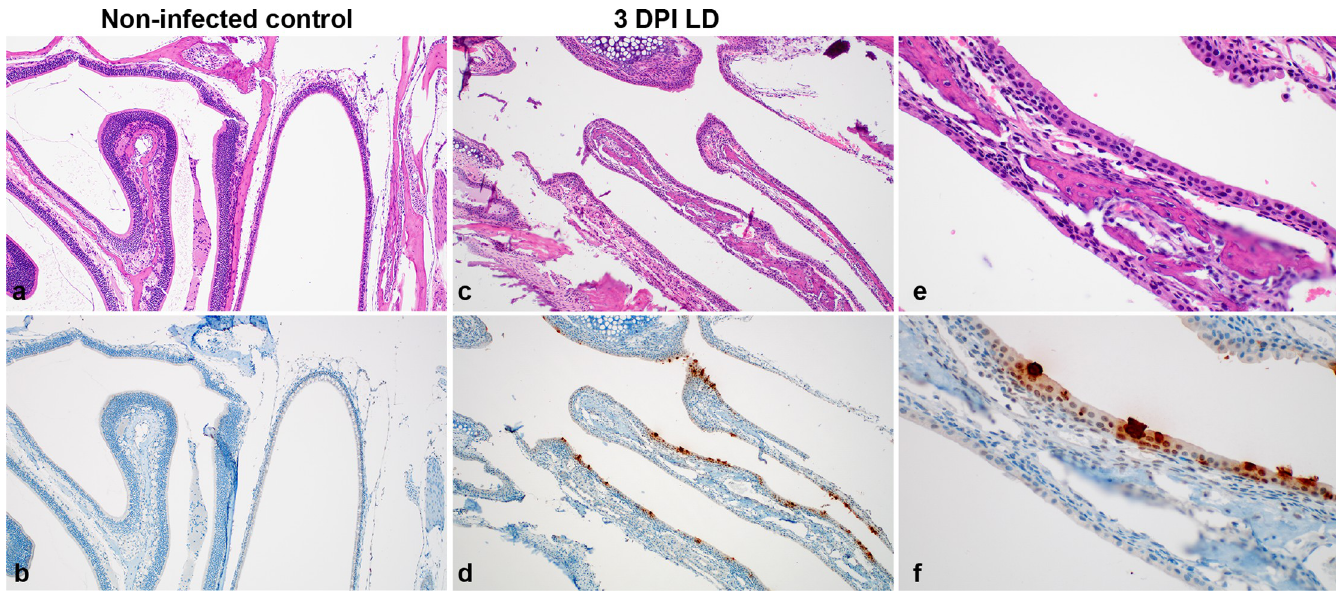
Fig 5. Histologic features of nasal turbinates of SARS-CoV-2 infected mice. a . Normal nasal turbinates from γ -irradiated SARS-CoV-2 inoculated control mouse lined by olfactory and respiratory epithelium. b . Absence of SARS-CoV-2 antigen immunoreactivity in respiratory and olfactory epithelial cells of low dose inoculated animal at 3 DPI. c. 3 DPI nasal turbinates lack inflammation but d. exhibit cytoplasmic immunoreactivity (brown) of respiratory epithelial cells for SARS-CoV-2 antigen. e . Higher magnification of respiratory epithelium. f . Higher magnification showing SARS-CoV-2 antigen immunoreactivity in ciliated respiratory epithelial cells. Magnification: a, b, c, d = 100 x; e, f = 400 x.